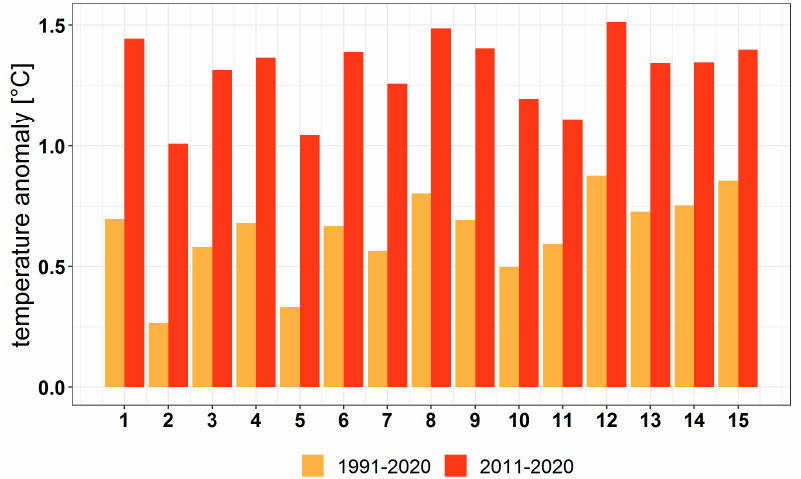
Figure 9. The differences in mean annual temperature over the last 30 years compared to 1951–1960 decade for the main forest types.